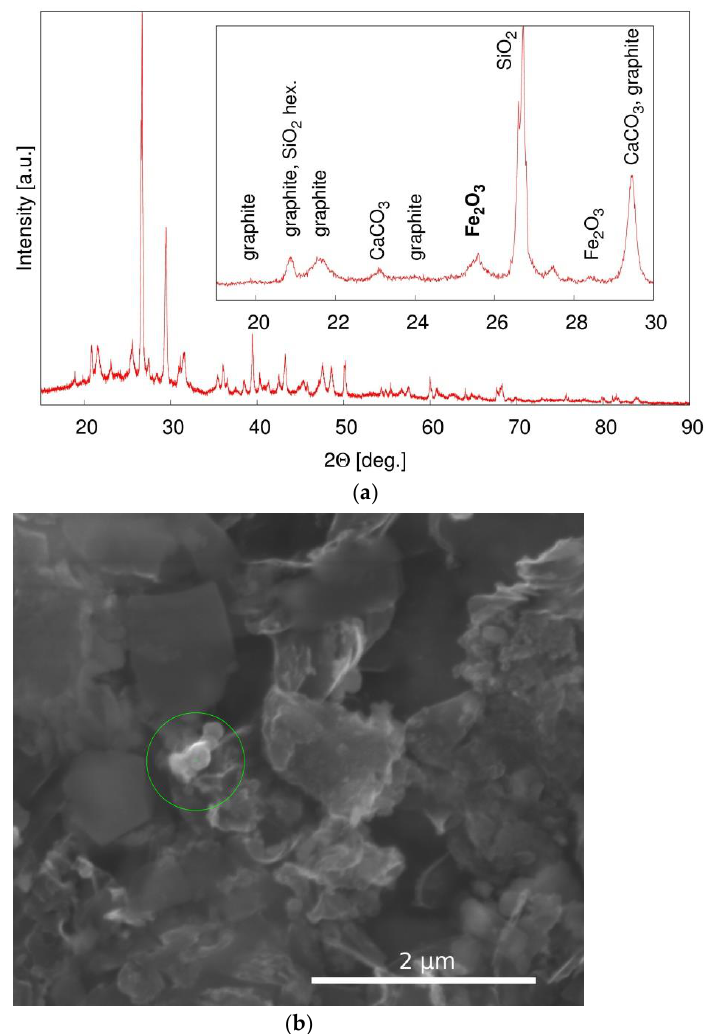
Figure 2. ( a ) Diffraction pattern of ChFe6-1000 sample; inset: close-up of the main maxima; ( b ) SEM image of the ChFe6- 1000 sample with particle identified as iron oxide based on EDX analysis. image of the ChFe6-1000 sample with particle identified as iron oxide based on EDX